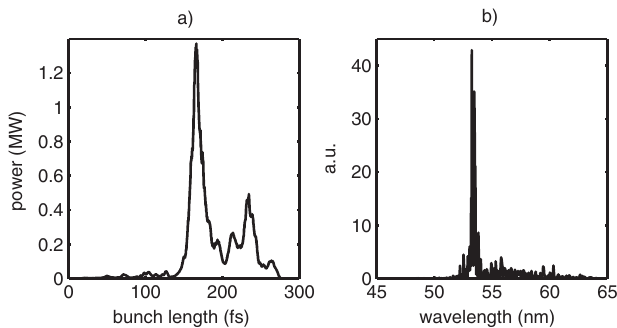
FIG. 7. Distribution of power along the bunch (a), and spectral power distribution (b), at the end of the radiator tuned to the 5th harmonic.